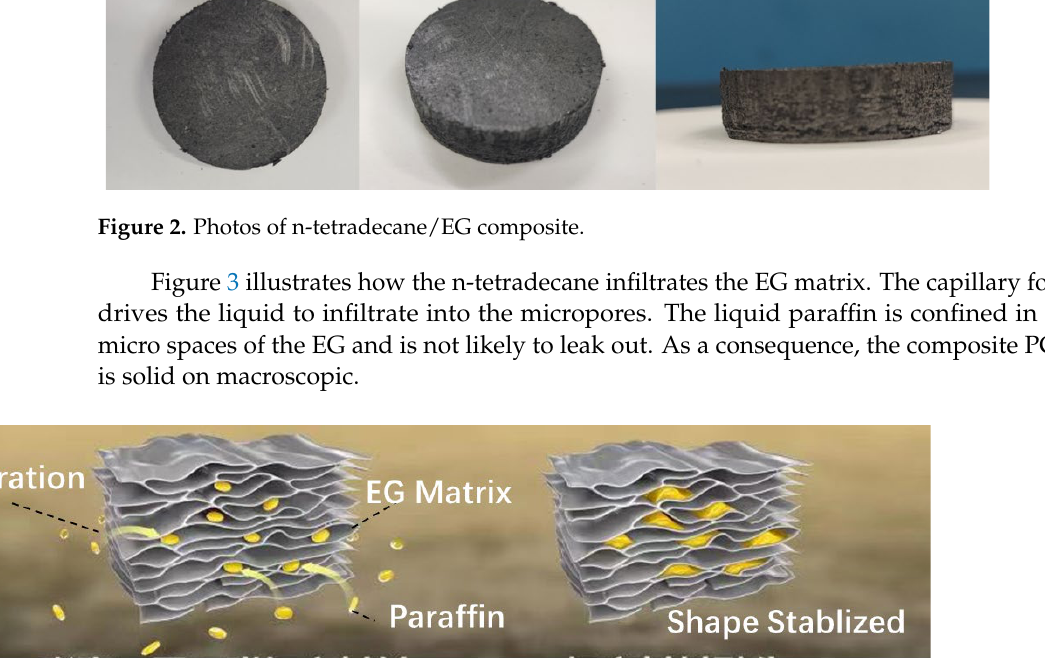
Figure 3. Schematic of paraffin infiltrated into the EG matrix.